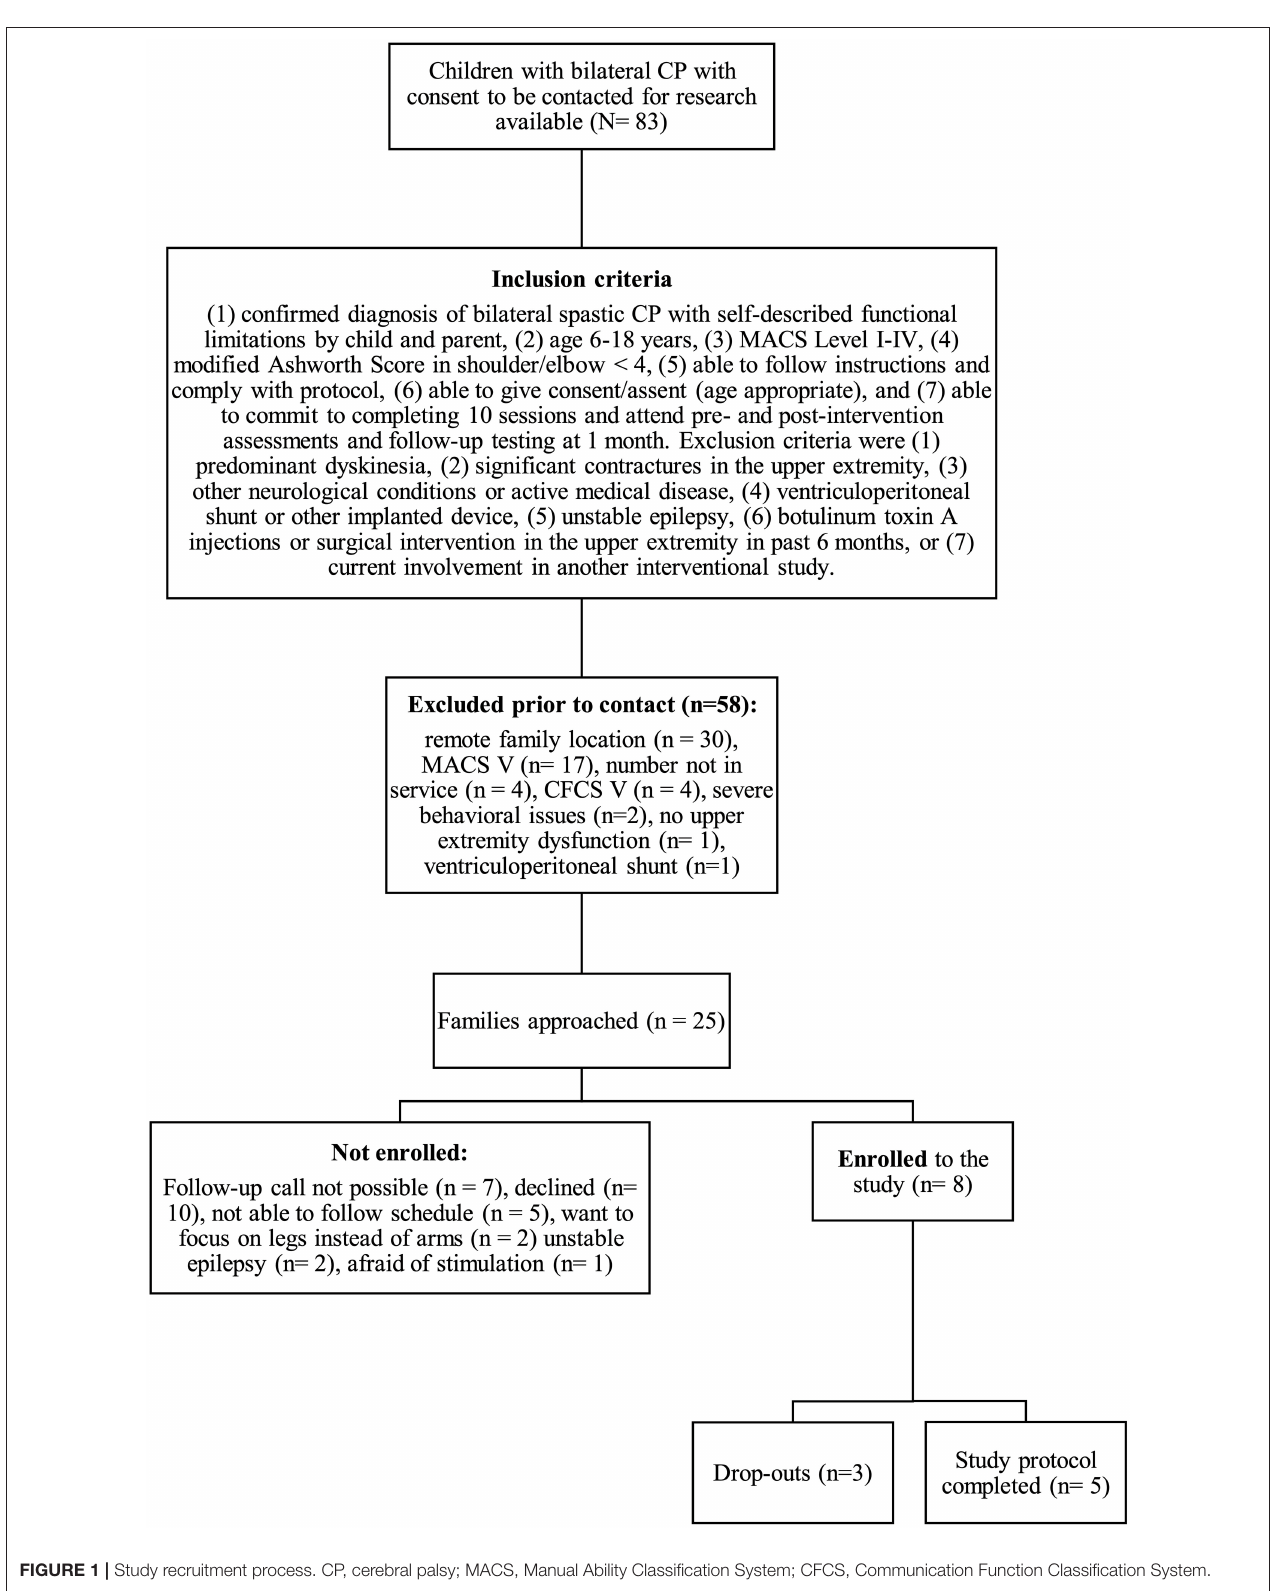
FIGURE 1 | Study recruitment process. CP, cerebral palsy; MACS, Manual Ability Classification System; CFCS, Communication Function Classification System.